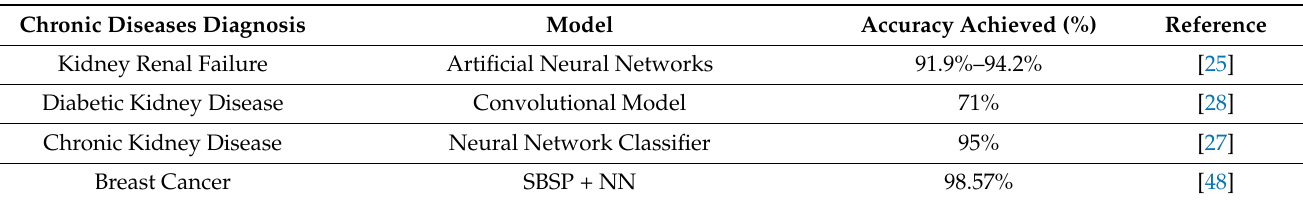
Table 1. Comparative Accuracy analysis of the diagnosis of Chronic Diseases from